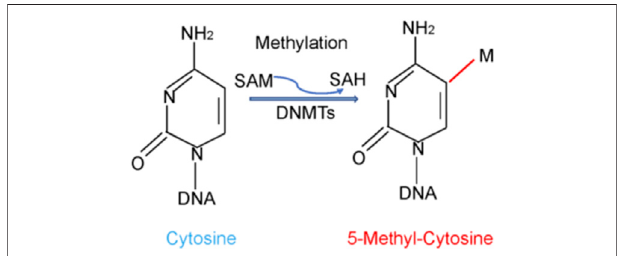
FIGURE1| DNAmethylationisregulatedbyDNMTs.DNAmethylationis often regulated by DNA methyltransferases (DNMTs), which catalyzed methyl groupfromS-adenylmethionine(SAM)toC-5positionofthecytosineresidue.